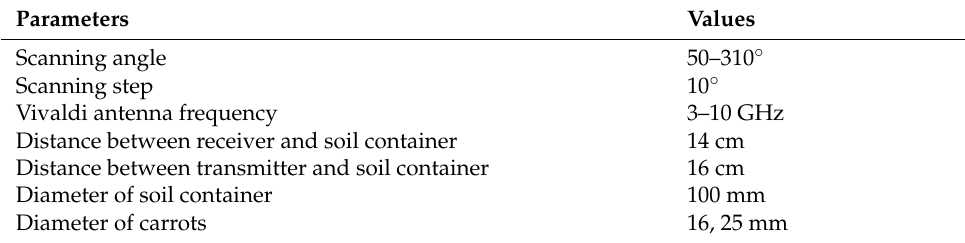
Table 2. Experimental